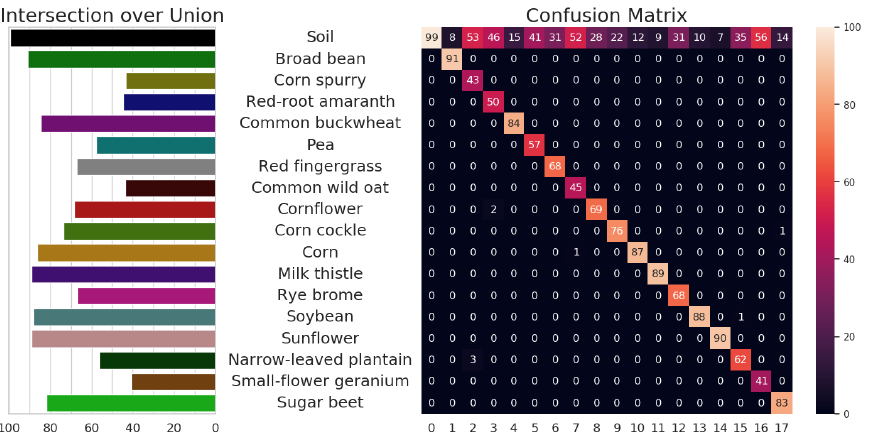
Figure 5. Performance of RGB-D semantic segmentation model trained on full-scale (1280 × 960 pixels) WE3DS dataset. Barplot ( left ) shows per class Intersection over Union IoU c . The confusion matrix ( right ) shows the ground-truth pixels (x-axis) and predicted pixels (y-axis) per class in percent. On the x-axis, 0 stands for class soil and positive integer values refer to the plant IDs, see Table S1.